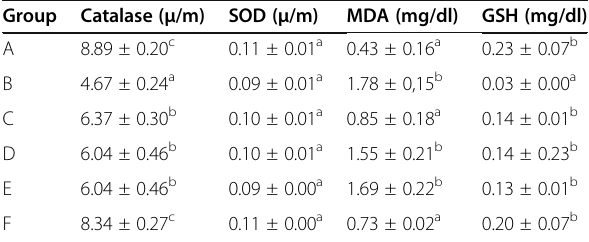
Table 4 Effect of the aqueous leaf extract of V. amygdalina and B. tenoreana on oxidative stress markers of alloxan-induced diabetic rats Group Catalase ( μ /m) SOD ( μ /m)